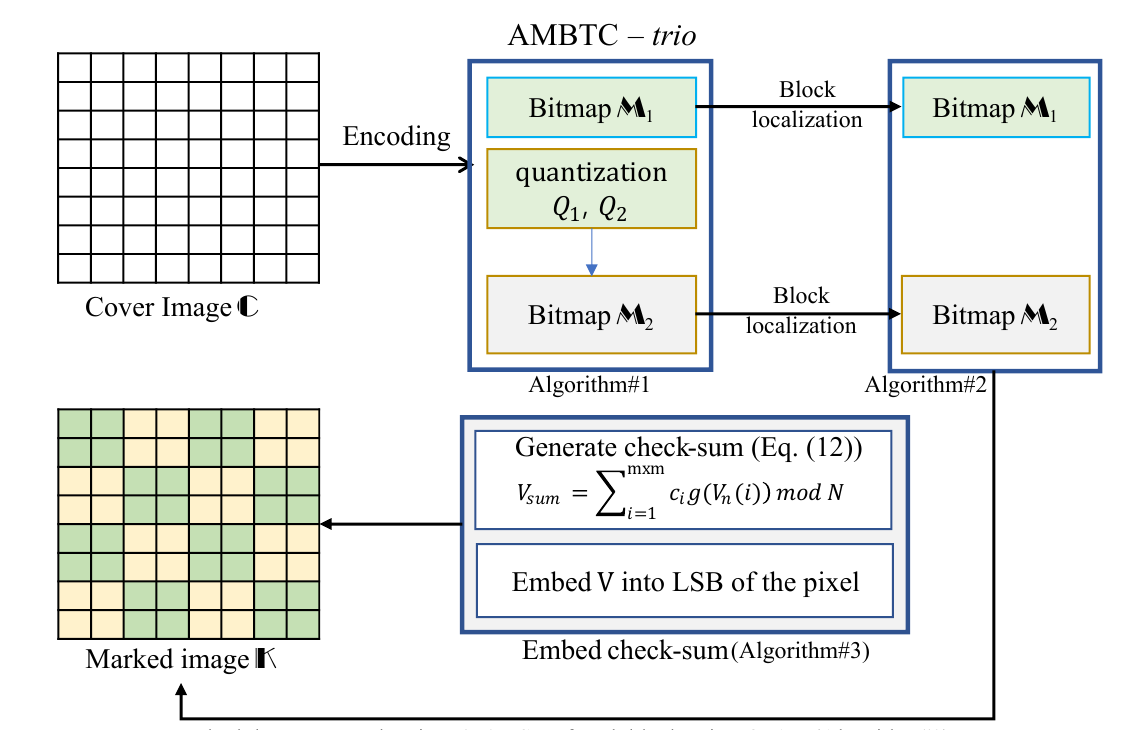
Figure 2. Block diagram for generating a watermarked image using AMBTC and the proposed embedding scheme (See Algorithms 1–3).